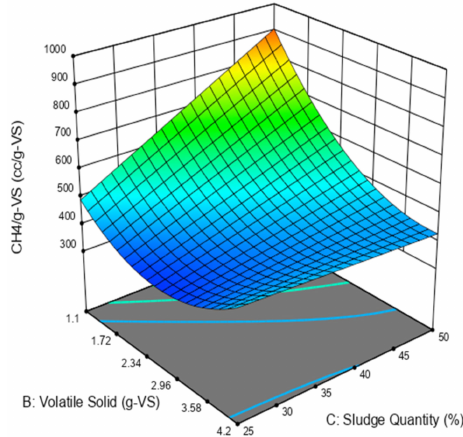
Figure 37. 3-D surface Plot illustrates the effect of volatile solid and sludge quantity on CH 4 /g-VS% at 37 ◦